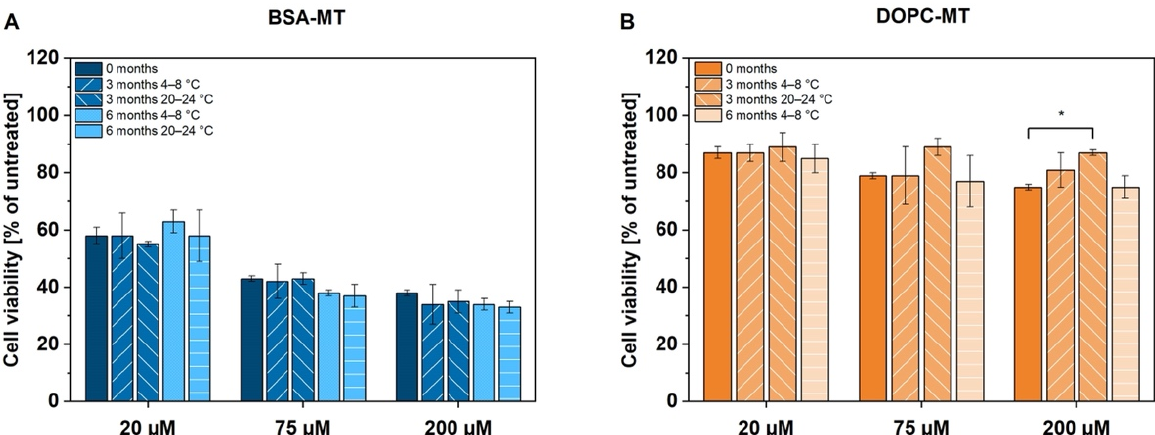
Figure 4. Therapeutic stability analysis of ( A ) albumin-stabilized mitotane (BSA-MT) and ( B ) lipo- somal mitotane (DOPC-MT) under different storage conditions. Cell viability of NCI-H295R cells was analyzed by the CellTiter-Glo ® luminescent cell viability assay 24 h after treatment with freshly prepared particles and particles stored for 3 and 6 months at 4–8 °C and 20–24 °C, respectively. Significant differences were evaluated via one-way ANOVA and Dunnett’s post-hoc test (* p < 0.05, further differences were not significant). Data are expressed as mean ± SD, n = 3.